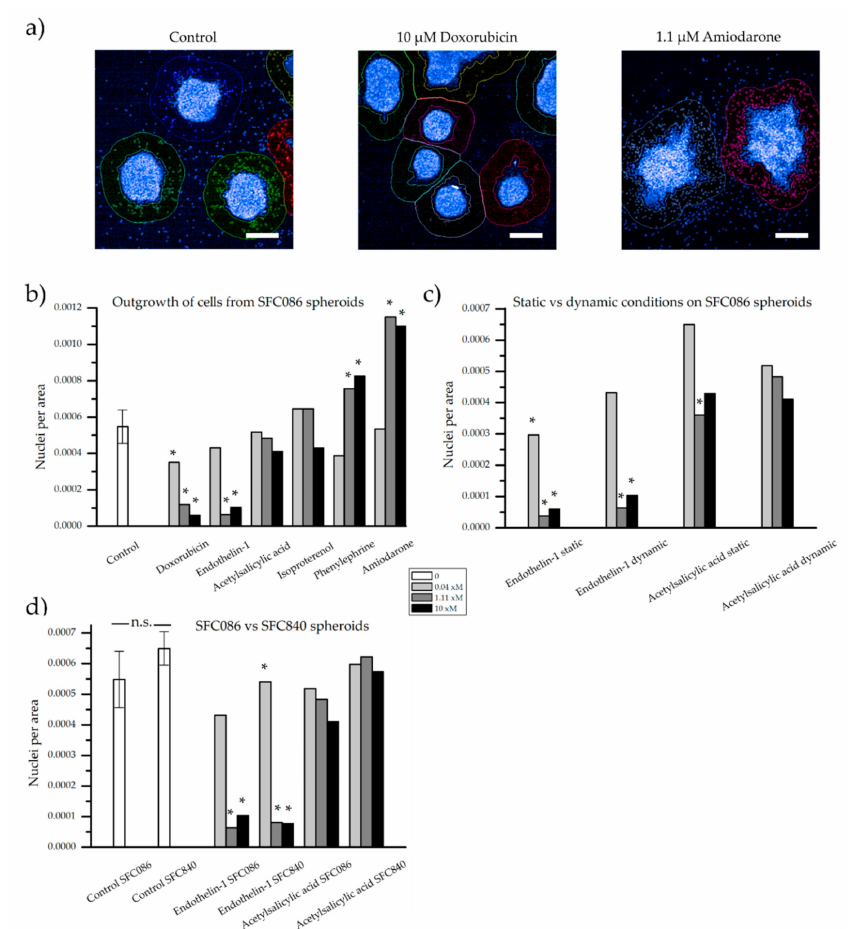
Figure 6. Quantification of the number of nuclei visible outside a defined area of the spheroids. ( a ) Examples of the applied contours around spheroids stained with Hoechst 33342 and captured by high content imaging. Number of nuclei per area of analysis from ( b ) the SFC086 cell line under dynamic conditions exposed to six compounds at three concentrations, ( c ) the SFC086 cell line at static and dynamic conditions exposed to two compounds, and ( d ) the SFC086 cell line compared to the SFC840 cell line when exposed to two compounds. Control samples are presented as mean ± standard deviation of three experiments, * denotes a significant difference of the sample from the dynamic control. No significance (n.s.) was observed between the two control samples (SFC086 and SFC840). For endothelin-1, x = n (nM). For all other compounds, x = µ ( µ M). Scalebar represents 200 µ